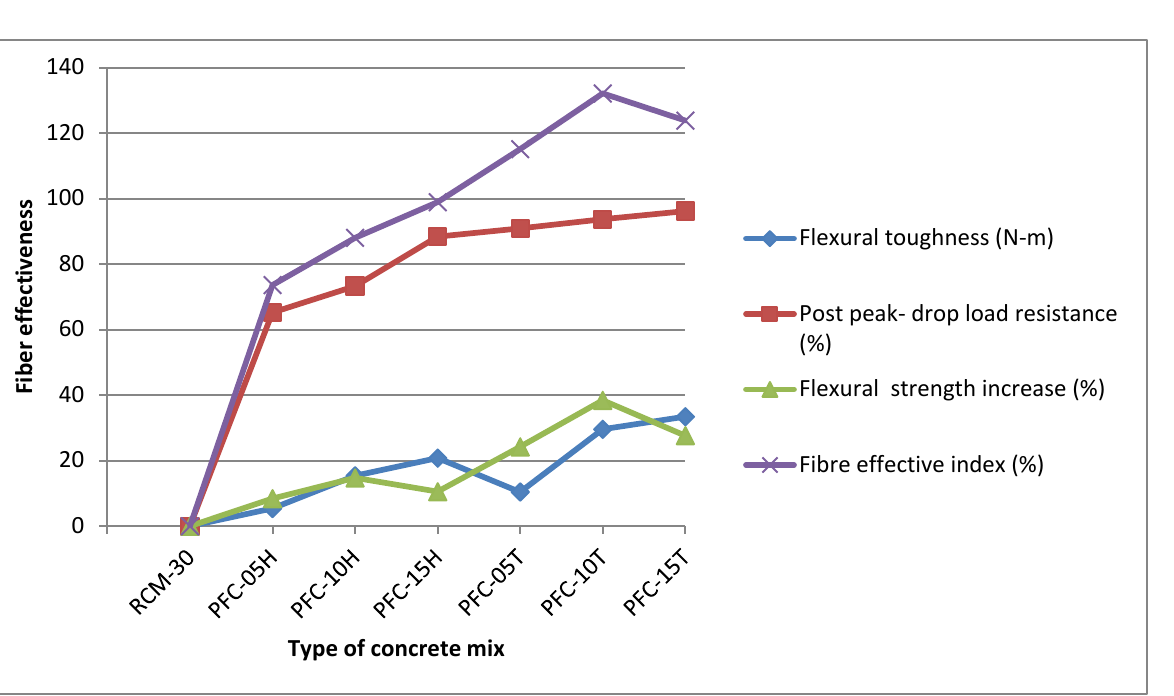
Figure 15. Fiber effectiveness for various flexural parameters of concrete mixes.